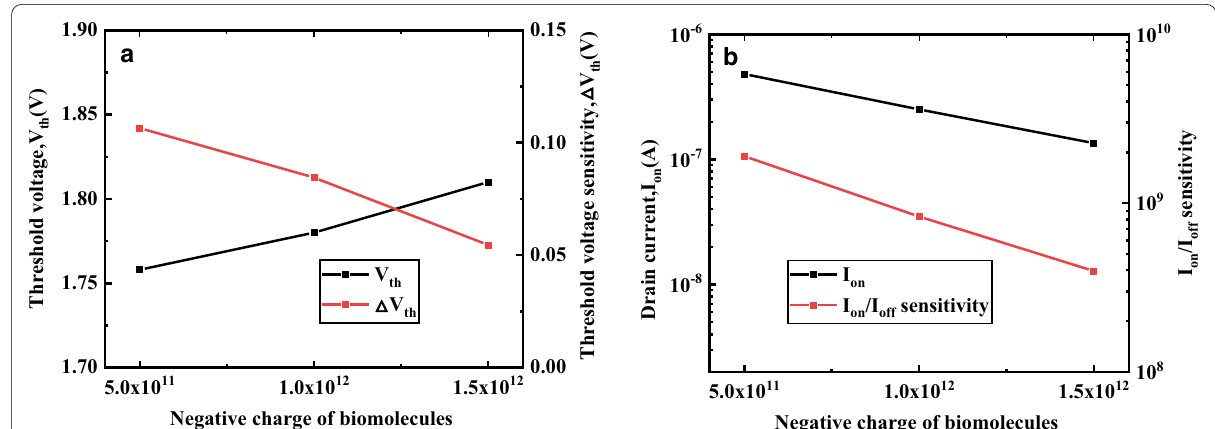
Fig.10 a Effect of different negative charge of biomolecules on I on , I on / I off sensitivity, b V th and △ V th of DM-DSTGTFET at V g k 2.5 and T c 5 = =